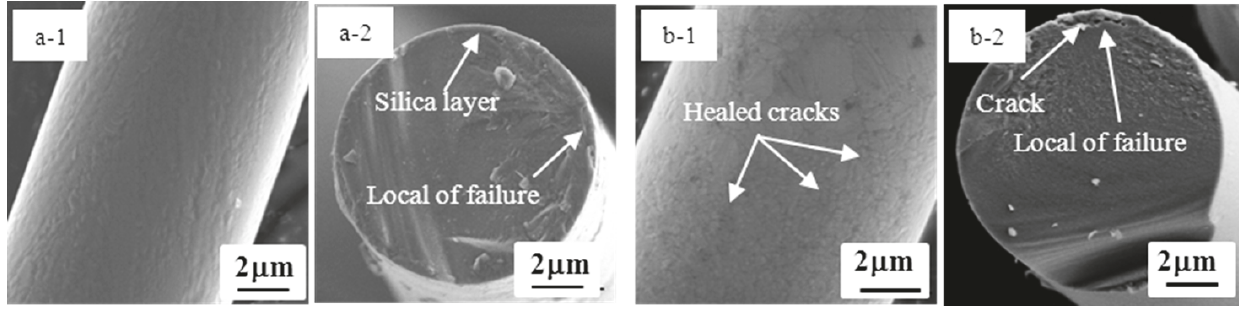
Figure 6: The morphologies of KD-S after annealing at 1400 ∘ C for 1 h. (a) Under simulated atmosphere. (b) Under dry